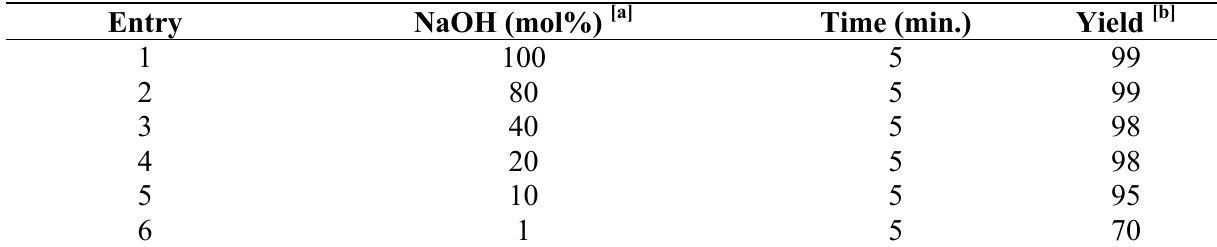
Table 1. Claisen-Schmidt reactions of 1b with 2a using various mol% of NaOH by grinding in a mortar and pestle for 5